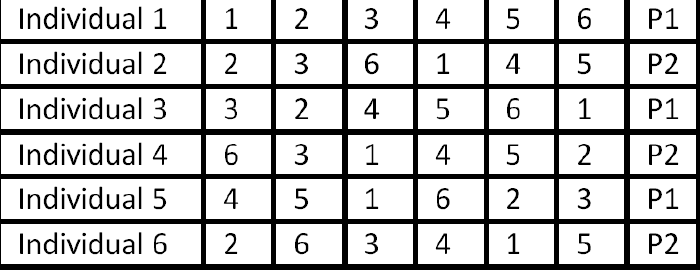
Figure 7. Sending mutated segments of the population to all processes in MiniGrid. Figure 8 shows the final population created after applying the distributed mutation and conducting the segments migration between the MiniGrid processes.